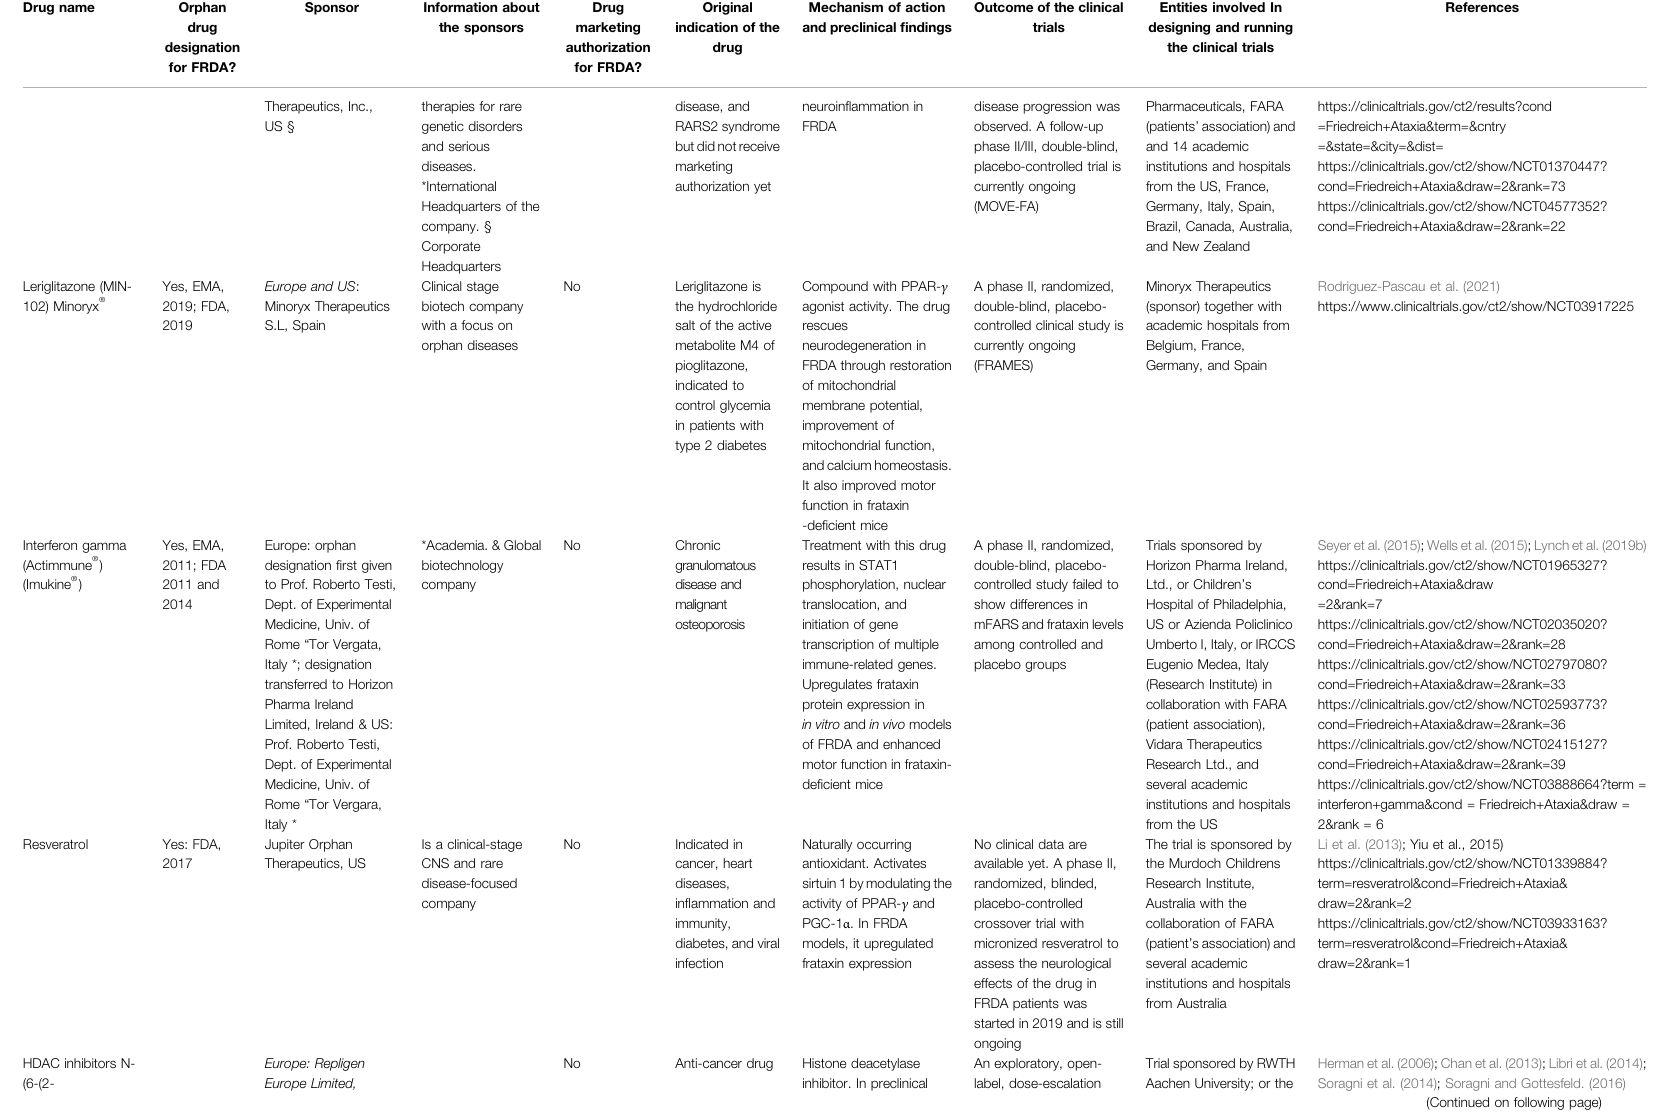
TABLE 2| ( Continued ) List of the repurposed drugs, with and without orphan designation or drug marketing authorization for Friedreich ’ s ataxia (FRDA) mentioned in this article. The sponsors (entities involved in making the orphan designation request to EMA or the FDA), and the public or private organizations involved in designing and running the clinical trials are detailed. N/A (cid:1)